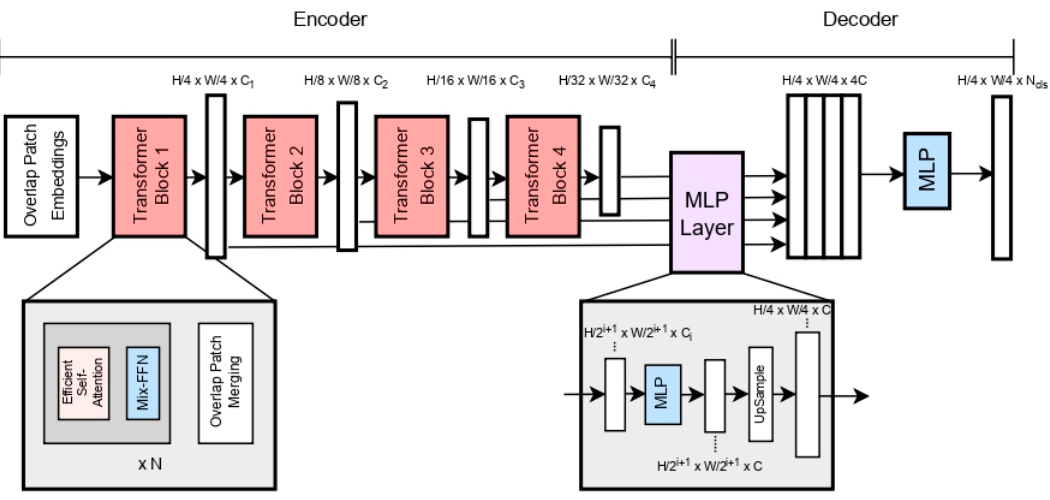
Figure 3. Structure diagram of SegFormer.